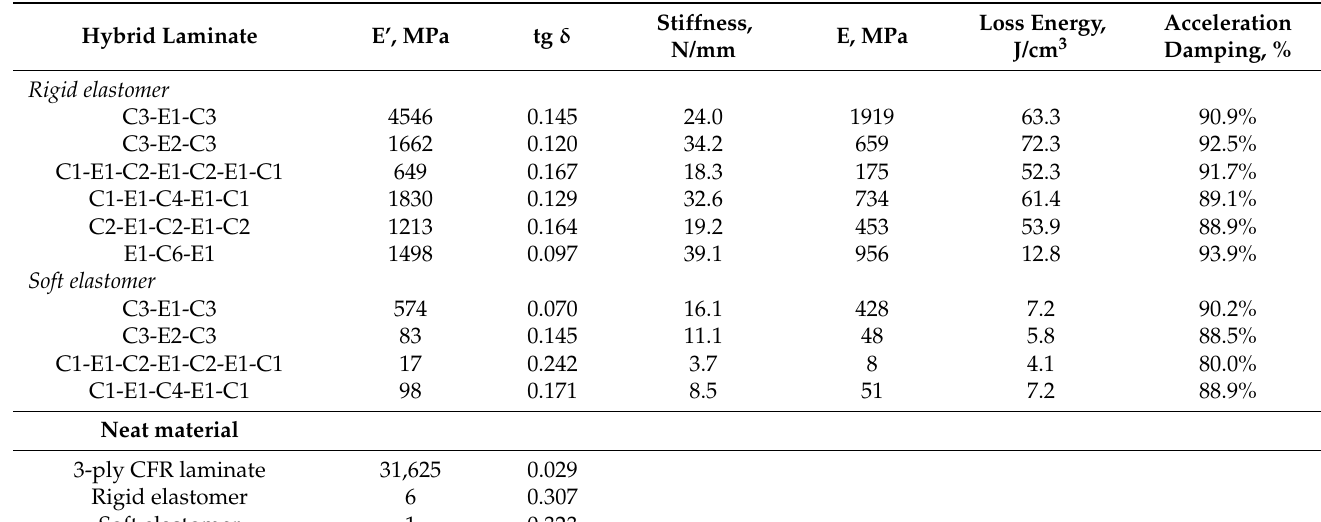
Table 3. Data from DMA and quasi-static bending tests on small